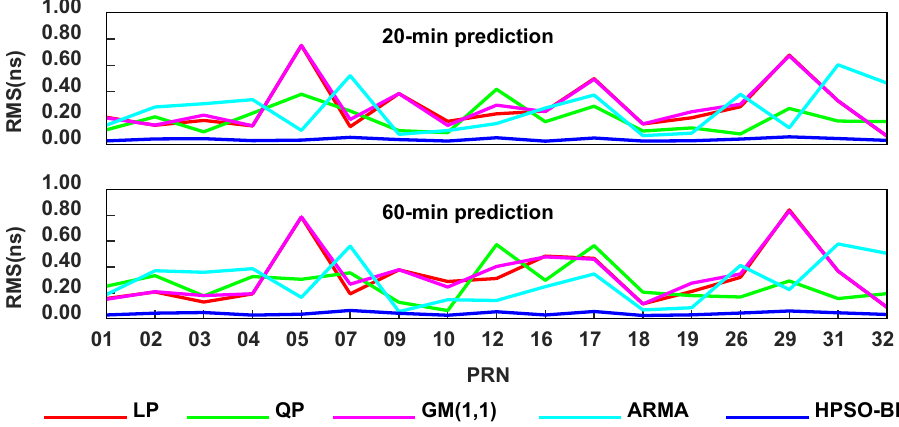
Figure 2. Prediction precision at 20-min and 60-min of five different models for each satellite (Satellite 24 is not shown in the figure. Specific results for satellite 24 are shown in Tables 6 and 7). Table 6. Statistics of average prediction results of five models for six different clock types (20-min forecasting) (Unit: ns, LP, QP, GM (1,1) and ARMA represent the linear polynomial model, the quadratic polynomial model, the gray system model and the auto regression moving average model, respectively).